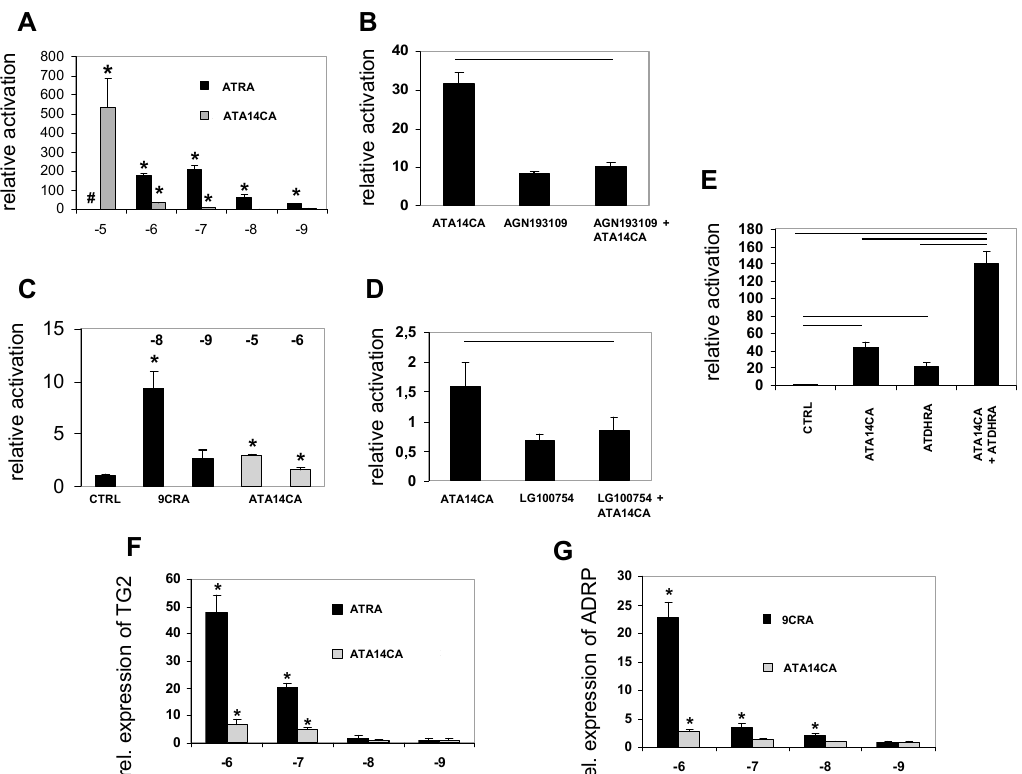
Figure 3. All- trans -apo-14´-carotenoic acid (ATA14CA) transactivates RAR- and RXR-mediated signalling and retinoid target gene expression. ( A ) Transcriptional activation of RAR-RXR heterodimer by ATRA and ATA14CA in RAR α -RXR α reporter HEK cells. ( B ) RAR-antagonist AGN168109 (10 − 5 M) diminishes ATA14CA (10 − 6 M) induced RAR α -mediated signalling ( p ≤ 0.05 indicated by the black line over the bars). ( C ) Transcriptional activation of RXR heterodimer by 9CRA and ATA14CA in RXR α -reporter HEK cells. ( D ) RXR-antagonist LG100754 (10 − 5 M) diminishes ATA14CA (10 − 6 M) induced RXR α -mediated signalling ( p ≤ 0.05 indicated by the black line over the bars). ( E ) Synergistic activation of ATDHRA (10 − 5 M) and ATA14CA (10 − 5 M) in RAR α -reporter HEK cells ( p ≤ 0.05 indicated by the black line over the bars). ( F ) ATRA and ATA14CA induce expression of the RAR target gene TG2 in treated MM6 cells. ( G ) ATRA and ATA14CA induce expression of the RXR / PPAR target gene ADRP in treated MM6 cells. # ATRA at concentrations of 10 − 5 M was cytotoxic. Significant values were marked with a *, when p ≤ 0.05 vs.